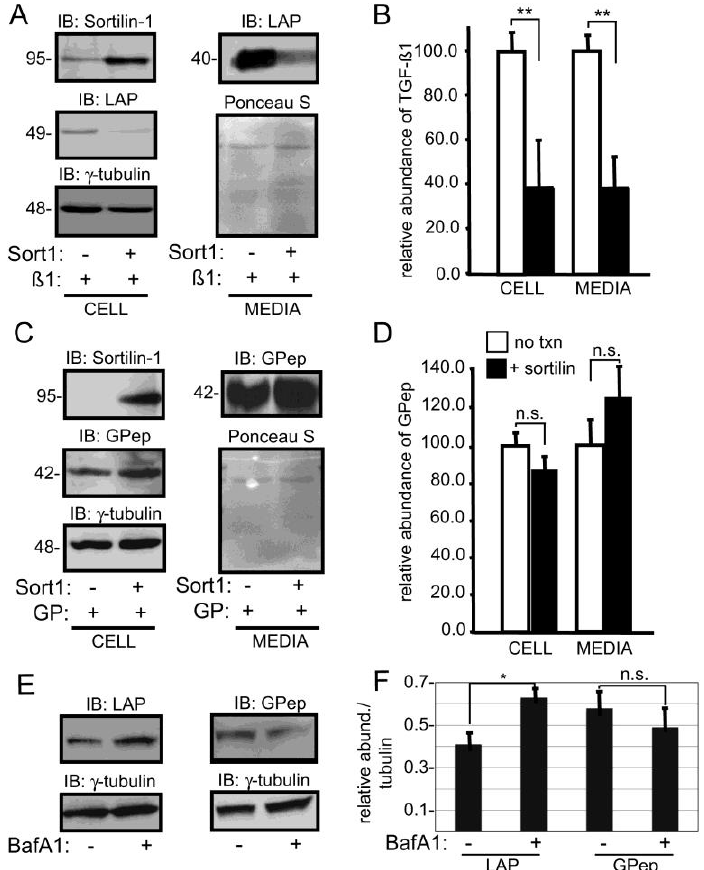
Figure 6. Co-expression o f latent TGFβ1 and sortilin in HeLa cells reduced latent TGFβ1 secretion. ( A ) HeLa cells were transfected with DNA encoding sortilin-1 and the TGF β 1 precursor and Western blot analysis performed on cell lysates or media. Immunoblots were subsequently reprobed with antibodies specific for γ -tubulin (cell) or were stained with Ponceau S (media) as a loading control. ( B ) Relative levels of TGF β 1 in the presence and absence of exogenously expressed sortilin were quantified based on band intensity on Western blots from three separate experiments. Average intensity in cells not transfected with sortilin-1 were set to 100. ( C , D ) Parallel experiments and quantification in HeLa cells transfected with DNA encoding sortilin-1 and human glycopepsinogen. ( E ) HeLa cells transfected with sortilin-1 and either TGF β 1 precursor or glycopepsinogen were treated with bafilomycin A1 (BafA1) to disrupt lysosomal function and subjected to SDS-PAGE and Western blot analysis; representative images are shown. ( F ) Quantification of the intensity of LAP or glycopepsinogen relative to γ -tubulin (n = 3), * p ≤ 0.05, ** p ≤